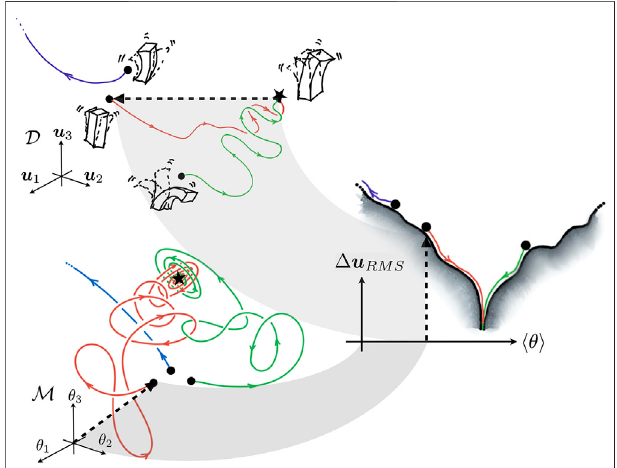
FIGURE 3 | A geometric view of the cost surface ’ s lower dimensional representation. The trajectories in D and M (red, green, and blue) are meant to represent how dif fi cult it is to visualize the paths in these high dimensional spaces. In MRE, the dimension of both is proportional to the number of voxels. To visualize the process of inference, we map our trajectories to a lowerdimensionalspacemadeofthenegativelogposterior(rootmeansquare of the displacement errors), and the mean property value. The RMS is proportional to the L 2 distance between the data displacements, u D , and model displacements, u M . The mean property value is proportional to the L 1 distance from the “ no property ” origin to the model point, θ . During single property inference the resulting lower dimensional representation is 1- dimensional,whilefortwopropertyinferenceitis2-dimensional.Notehowthe red and green trajectories eventually leads to the minimal RMS. The blue trajectory begins at a high enough error (near vanishing posterior), that our epistemicagentisincapableof fi ndingthecorrectdirectiontomovein M .The dimensionality of M is so large that nearly every direction leads to an increase in RMS displacement error, and the lower dimensional representation interprets this as rolling up the cost surface, leading to